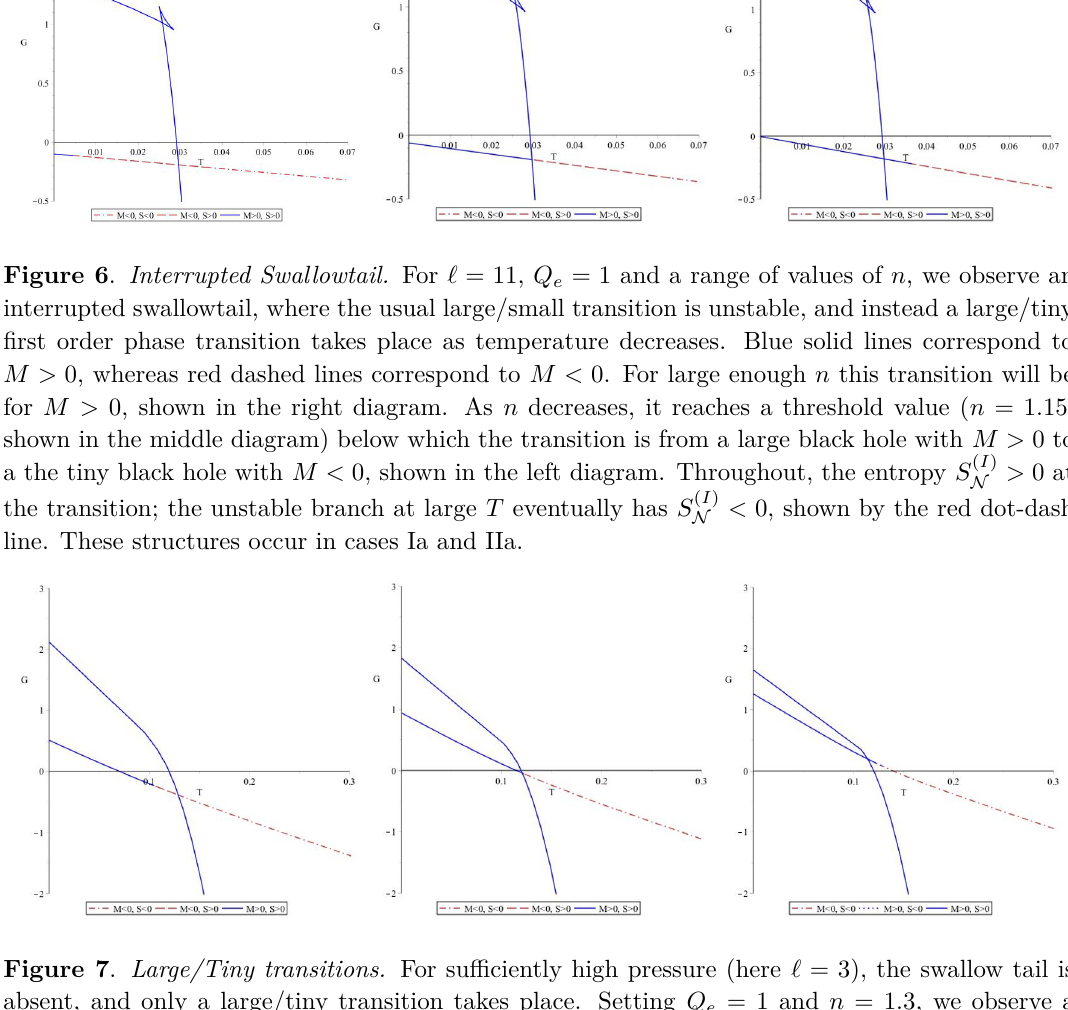
Figure 7 . Large/Tiny transitions. For sufficiently high pressure (here ‘ = 3 ), the swallow tail is absent, and only a large/tiny transition takes place. Setting Q e = 1 and n = 1 . 3 , we observe a situation analogous to that in figure 6, but with increasingly negative magnetic charge governing whether or not M < 0 for the tiny phase. Proceeding left to right, the left diagram has Q m = − 0 . 2 , the middle one Q m = − 0 . 55 and the right one Q m = − 0 . 8 . Blue solid lines correspond to M >